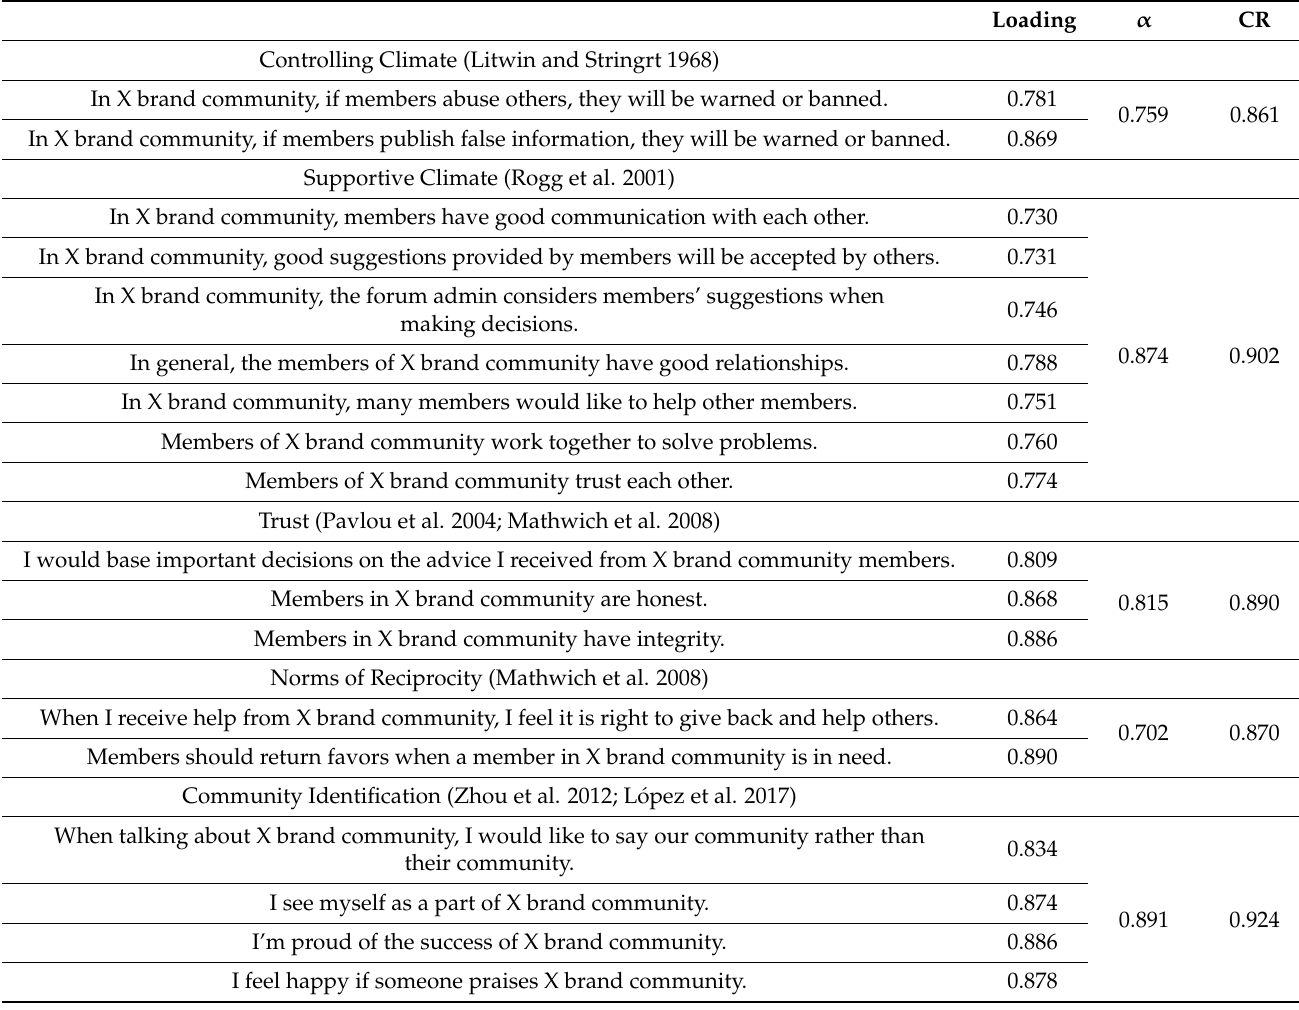
Table 2. Measurement items and validity